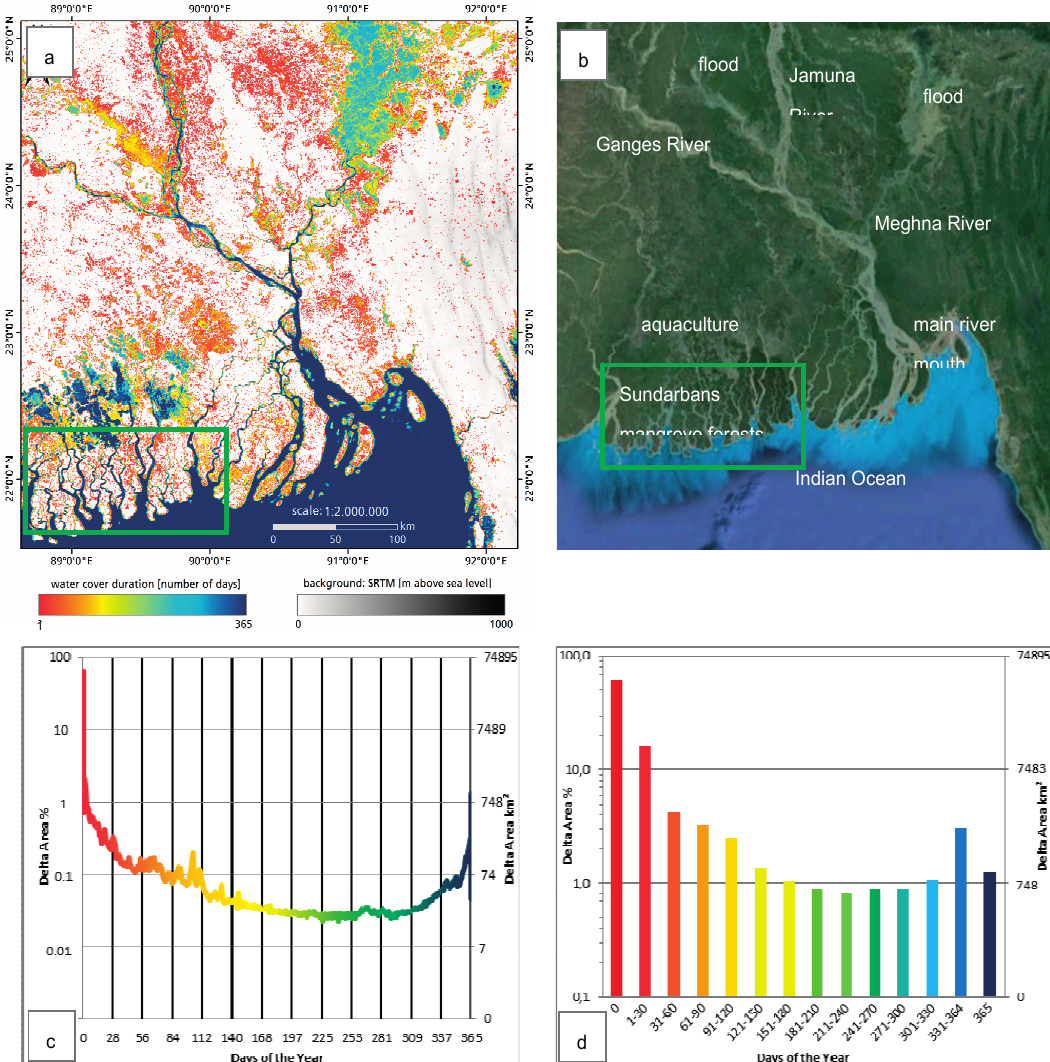
Figure 7. Intra-annual inundation patterns of the Ganges-Brahmaputra Delta in India/ Bangladesh, derived from an annual time series of daily temporal resolution for the year 2013. ( a ) intra-annual inundation dynamics, ( b ) optical data for